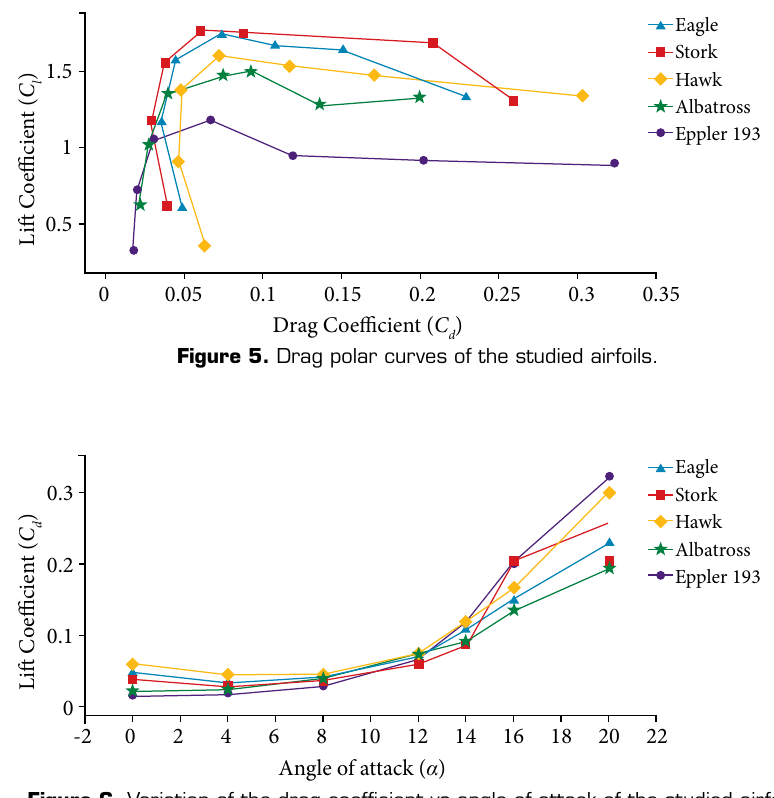
Figure 6. Variation of the drag coefficient vs angle of attack of the studied